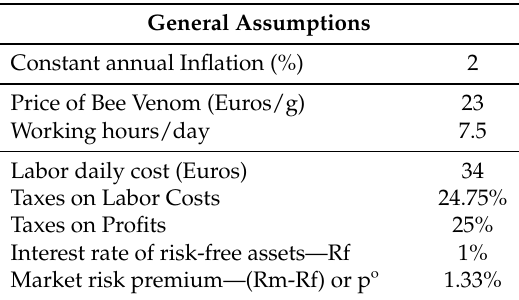
Table 6. General Assumptions.